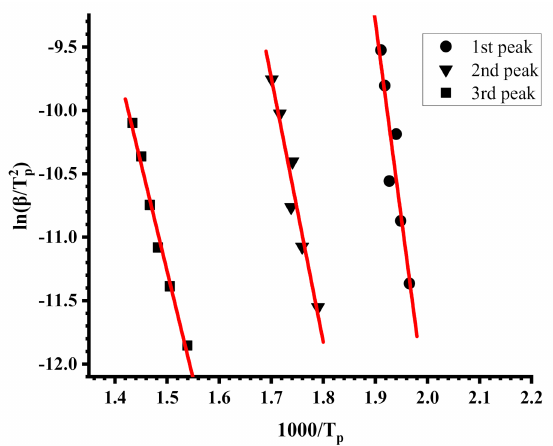
Figure 7. Kissinger plots for the PIBMA.